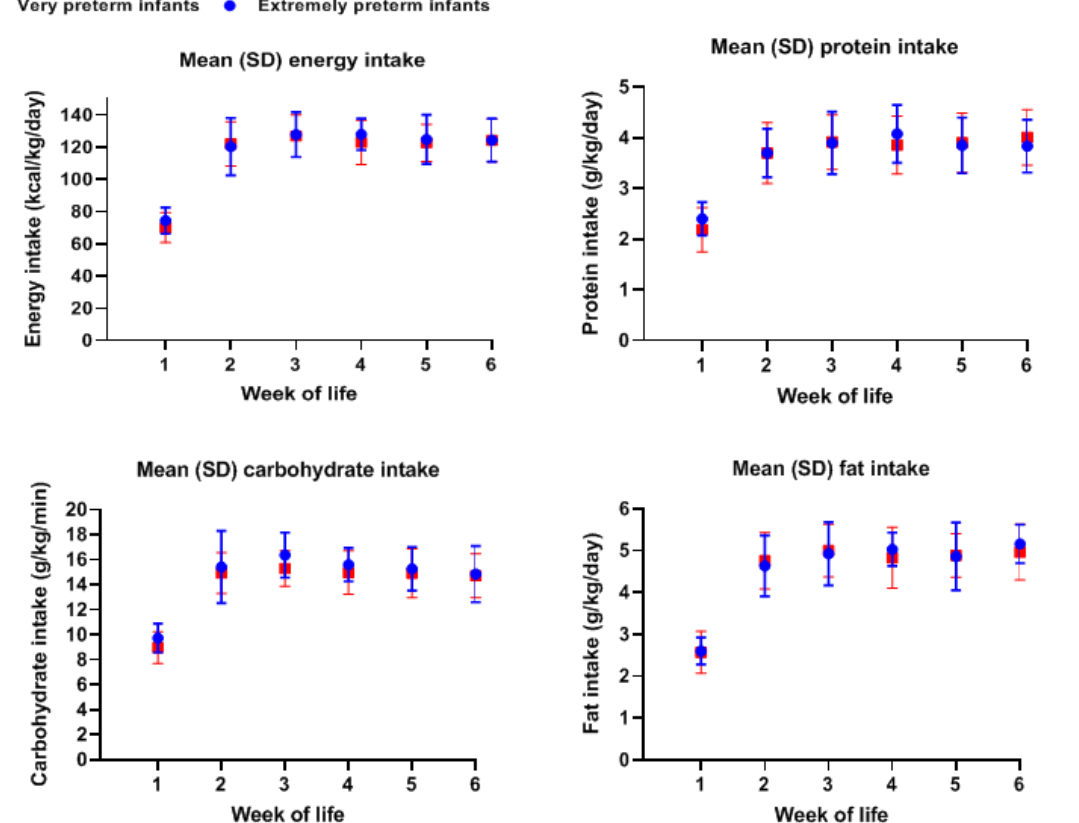
Figure 1. Nutrient intake in extremely and very preterm infants during the first weeks of life. Table 3. Macronutrient intake (% energy) in extremely and very preterm infants during the first four weeks of life.